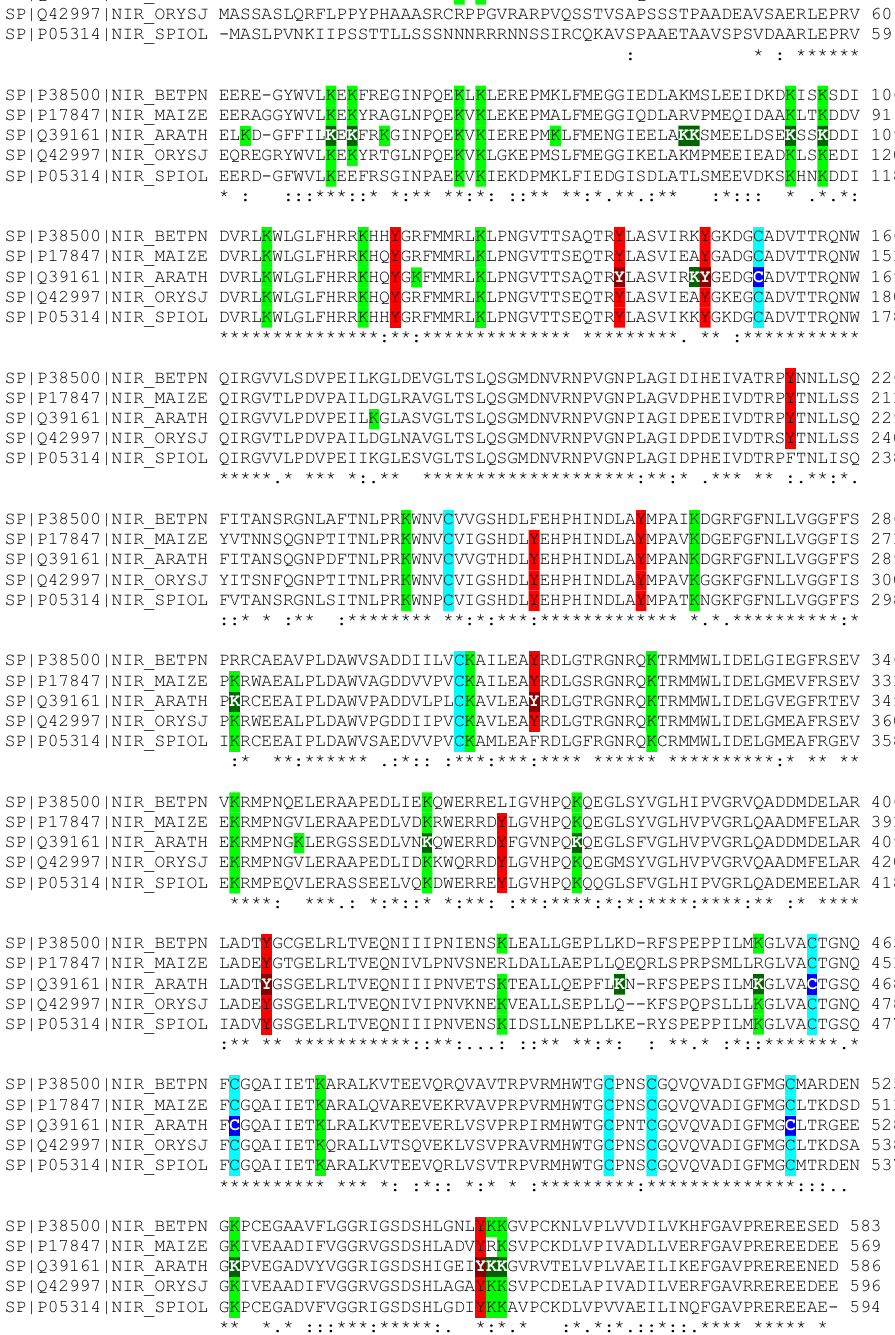
Figure 3. Post-translational modifications identified in planta for Arabidopsis NiR1. A, Multiple aligned amino acid sequences of different plant NiRs (silver birch BETPN; corn MAIZE; Arabidopsis thaliana ARATH; rice ORYSJ; and, spinach SPIOL) showing conserved residues highlighted in green, red and blue for K, Y and C, respectively. The Arabidopsis NiR1 tyrosine (Y), cysteine (C), and lysine (K) residues that were identified as nitrated, S-nitrosylated and ubiquitylated are shown in white characters on dark red, blue and green backgrounds, respectively. *,: and . represent fully conserved residues, and residues with similarity score >0.5 and <0.5, respectively